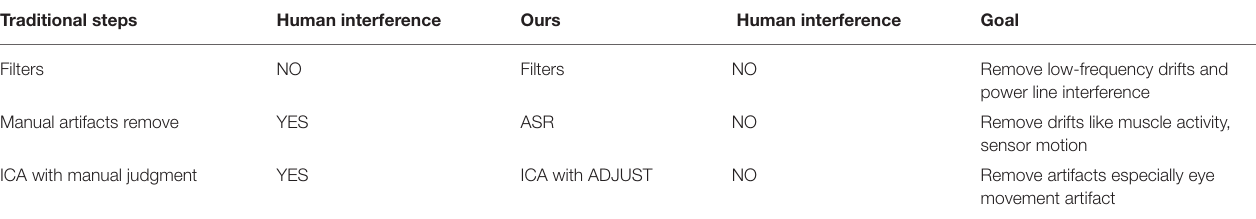
power line interference sensor motion movement